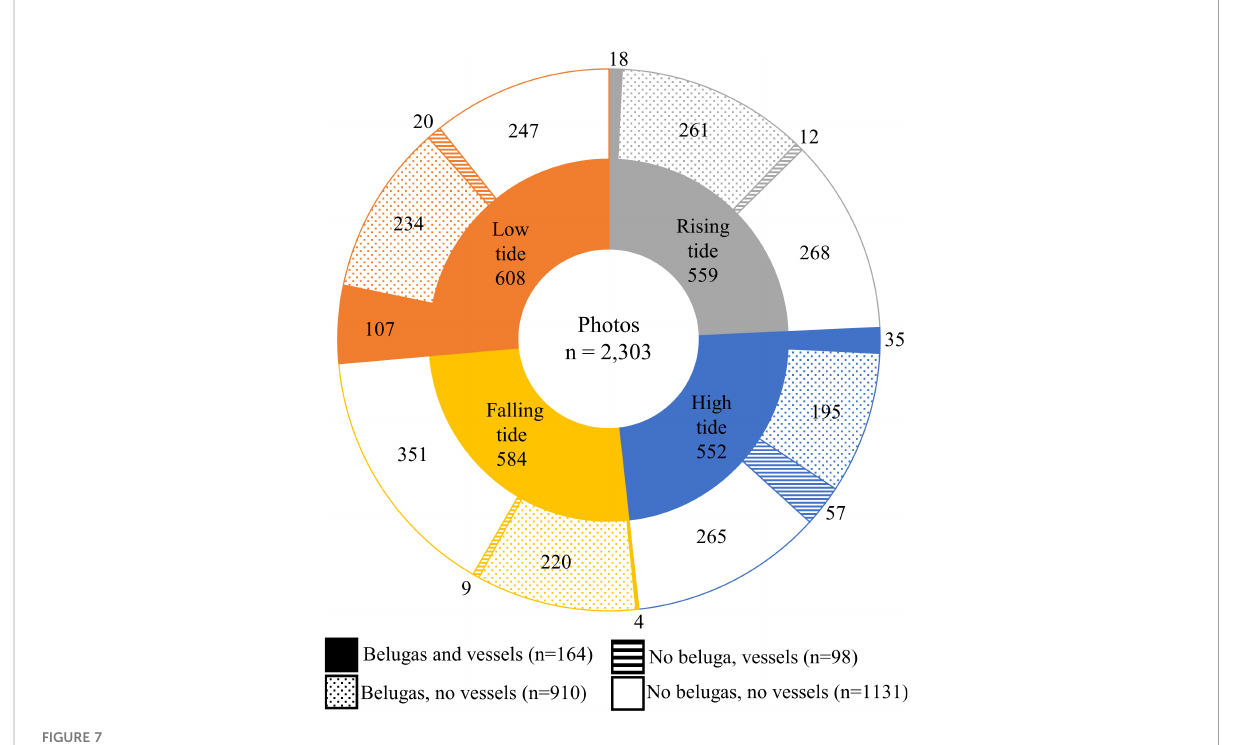
FIGURE 7 Proportion of photos with beluga, boats, and both within each tide